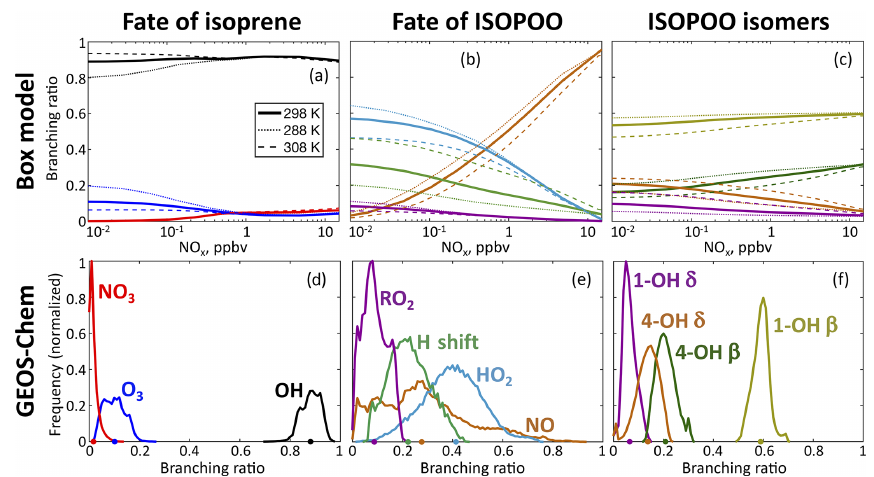
Figure 3. Fate of isoprene-hydroxy-peroxy radicals (ISOPOO) in the reduced Caltech isoprene mechanism (RCIM). The figure shows isoprene oxidation pathway branching ratios in a diurnal steady-state box model for clear-sky equatorial conditions (a, b, c) as a function of daytime mean NO x concentration and temperature, and the global spatial frequency distribution of annual mean branching ratios in GEOS- Chem (d, e, f) at 2 ◦ × 2 . 5 ◦ horizontal resolution. The GEOS-Chem frequency distributions are weighted by the amount of isoprene reacting in each grid box. Dots on the x axis indicate the global annual total reacting via each pathway. The distributions of ISOPOO isomers are weighted by their subsequent